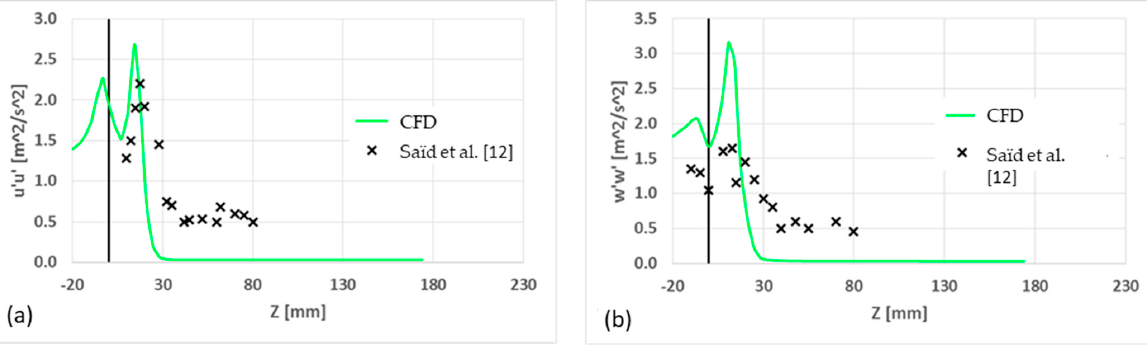
Figure 6. Reynolds stresses at section x = 16.7 [mm]—( a ) u’u’ component and ( b ) w’w’ component